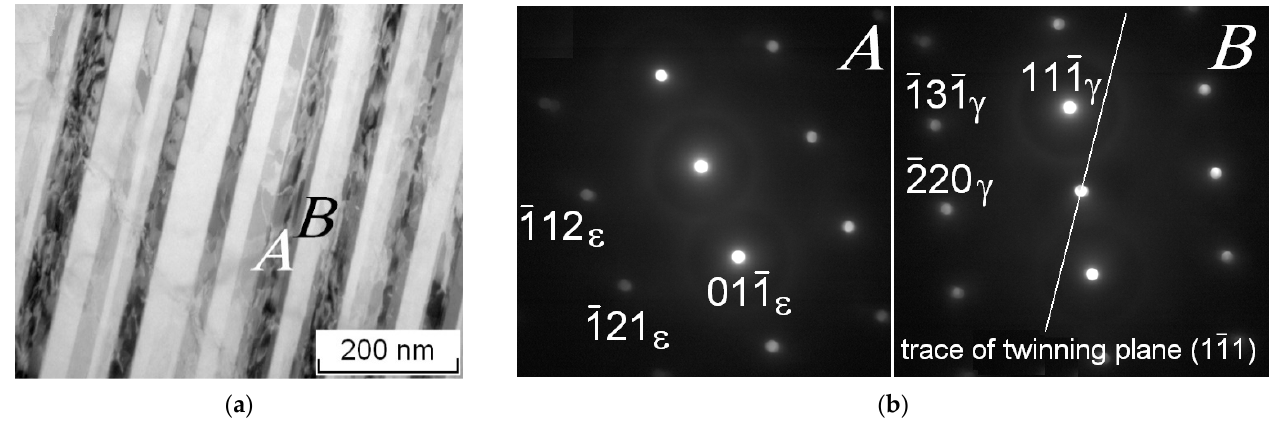
Figure 10. The microstructure in the uniformly deformed region of the sample after the tensile test at 77 K: ( a ) the bright-field image of ε -martensite plates and strain twins; ( b ) the reflex grid electron diffraction pattern of ε -martensite (z = [311] ε ) from the A microstructure area, and austenite (z = [112] γ ) from the B microstructure area; the line shows the trace of the (111) γ twinning plane.